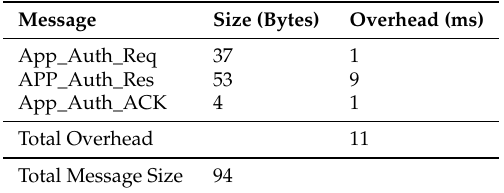
Table 10. Message size and overhead for the proposed protocol’s Default Option (DO).